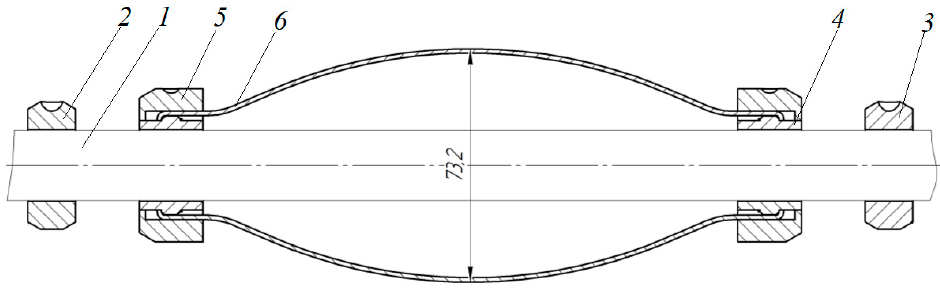
Figure 6. Centralizer for a PCP unit.